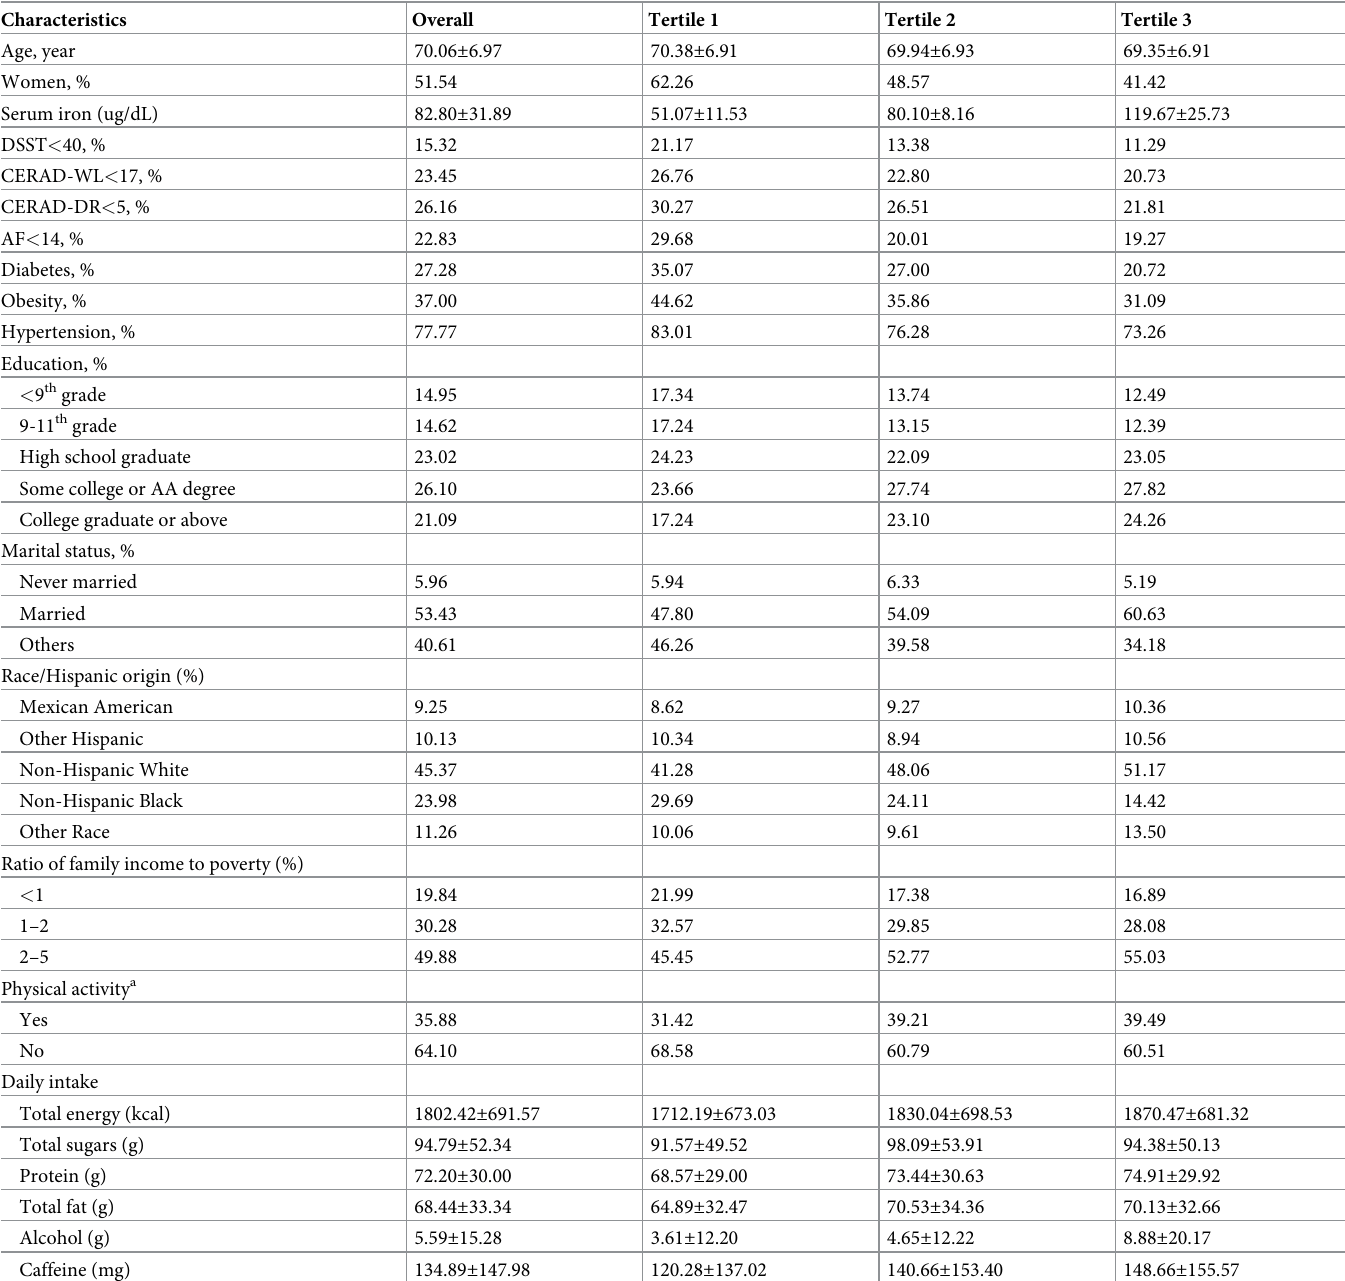
Table 1. Population characteristics by tertiles of serum iron concentrations (mean values: tertile 1: 51.07 ug/dL, tertile 2: 80.10 ug/dL, tertile 3: 119.67 ug/dL).